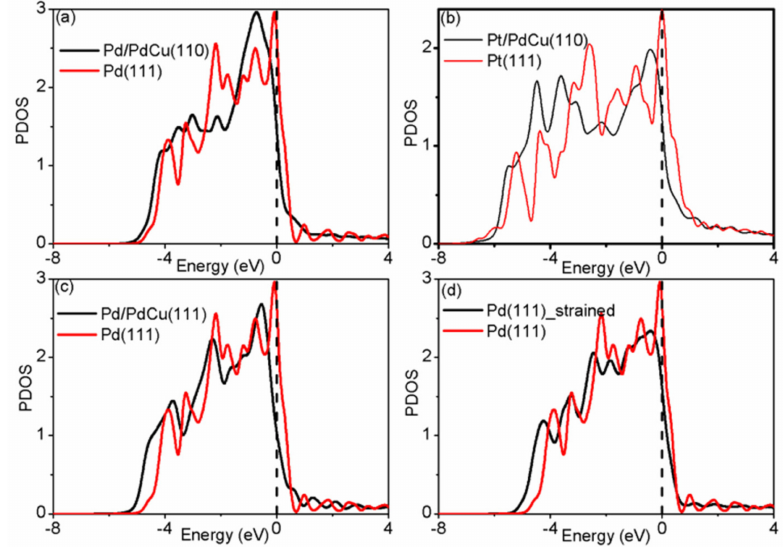
Figure 2. The calculated partial density of states (PDOS) for ( a ) Pd monolayer on top of intermetallic Pd–Cu; ( b ) Pt monolayer on top of intermetallic Pd–Cu; ( c ) Pd monolayer on top of Pd–Cu FCC alloy, and ( d ) compressed Pd(111). Noted that Pd/Pd–Cu(111) and compressed Pd(111) have the same strain up to 3.49%.